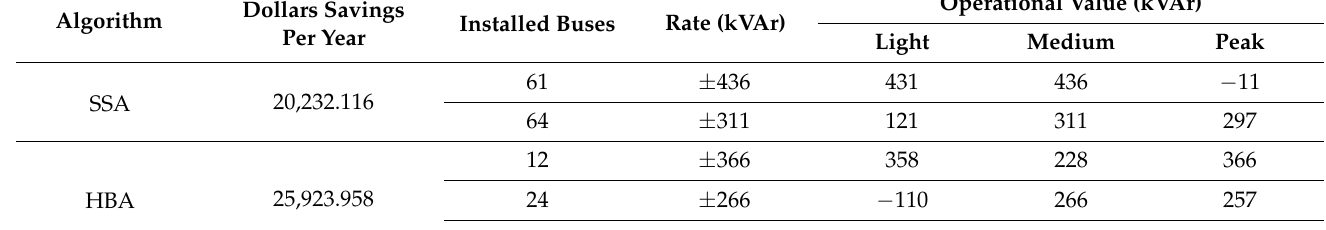
Figure 14. Minimum voltages for the IEEE 69-node system of the GBOC versus GBO, SSA, DMOA, DE, and HBA for Scenario 1.